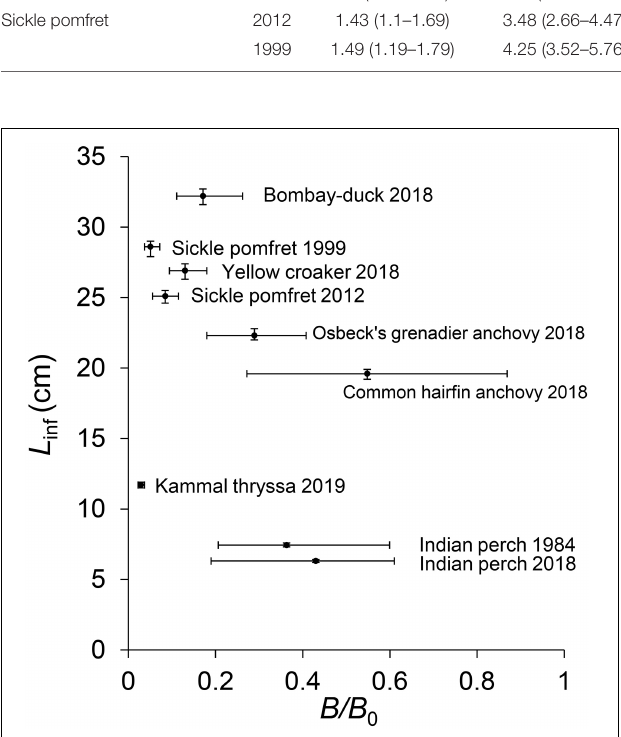
FIGURE 4 | The scatter plot of L inf (cm) and B / B 0 estimated from LBB with